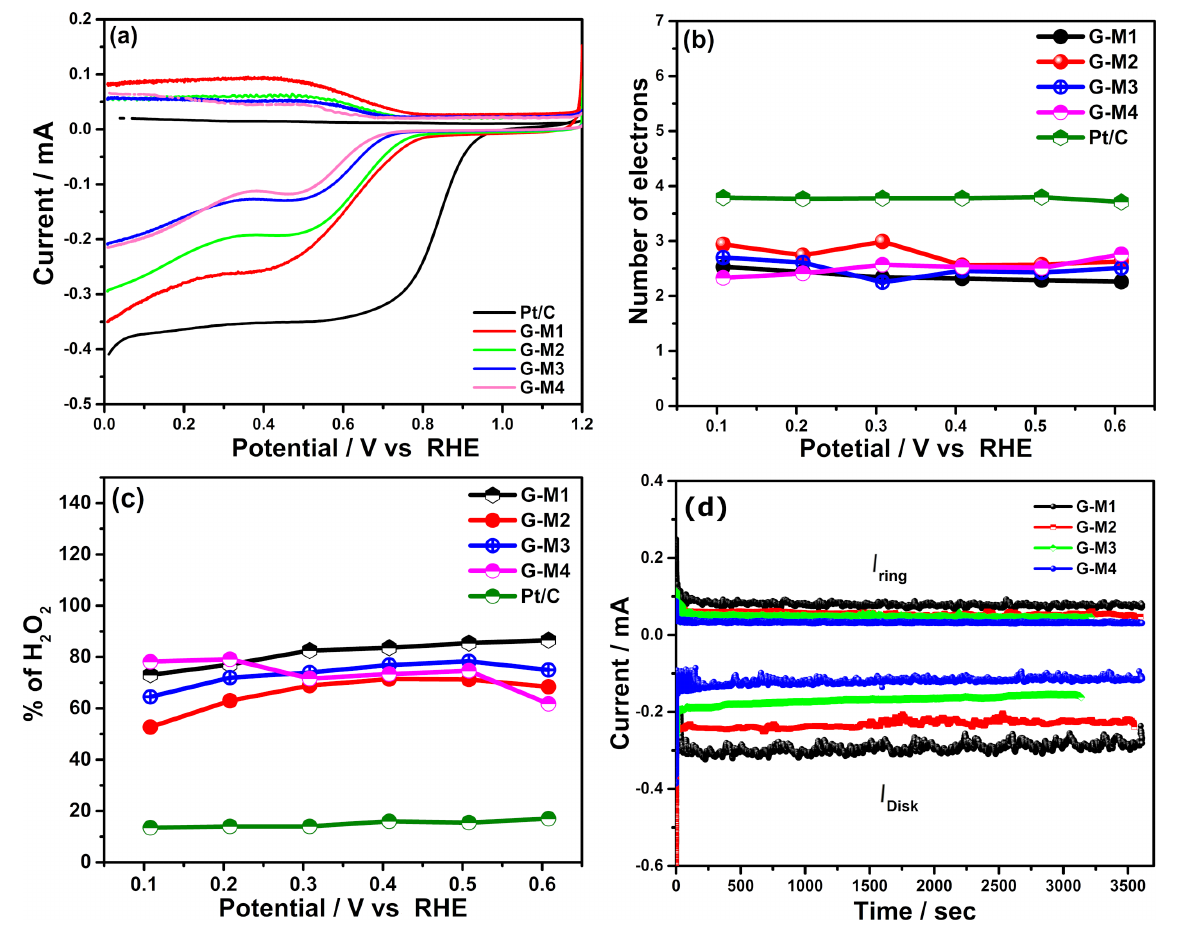
Figure 4: (a) LSV scans of O 2 reduction and H 2 O 2 (HO 2 − ) oxidation on different EEG-modified RRDE samples. (b) The number of electrons trans- ferred during ORR per O 2 molecule and (c) the percentage (%) of formed H 2 O 2 (calculated from Figure 4a) is shown. (d) Chronoamperograms of O 2 reduction and H 2 O 2 oxidation processes at 0.358 V and 1.5 V vs RHE on different electrodes.